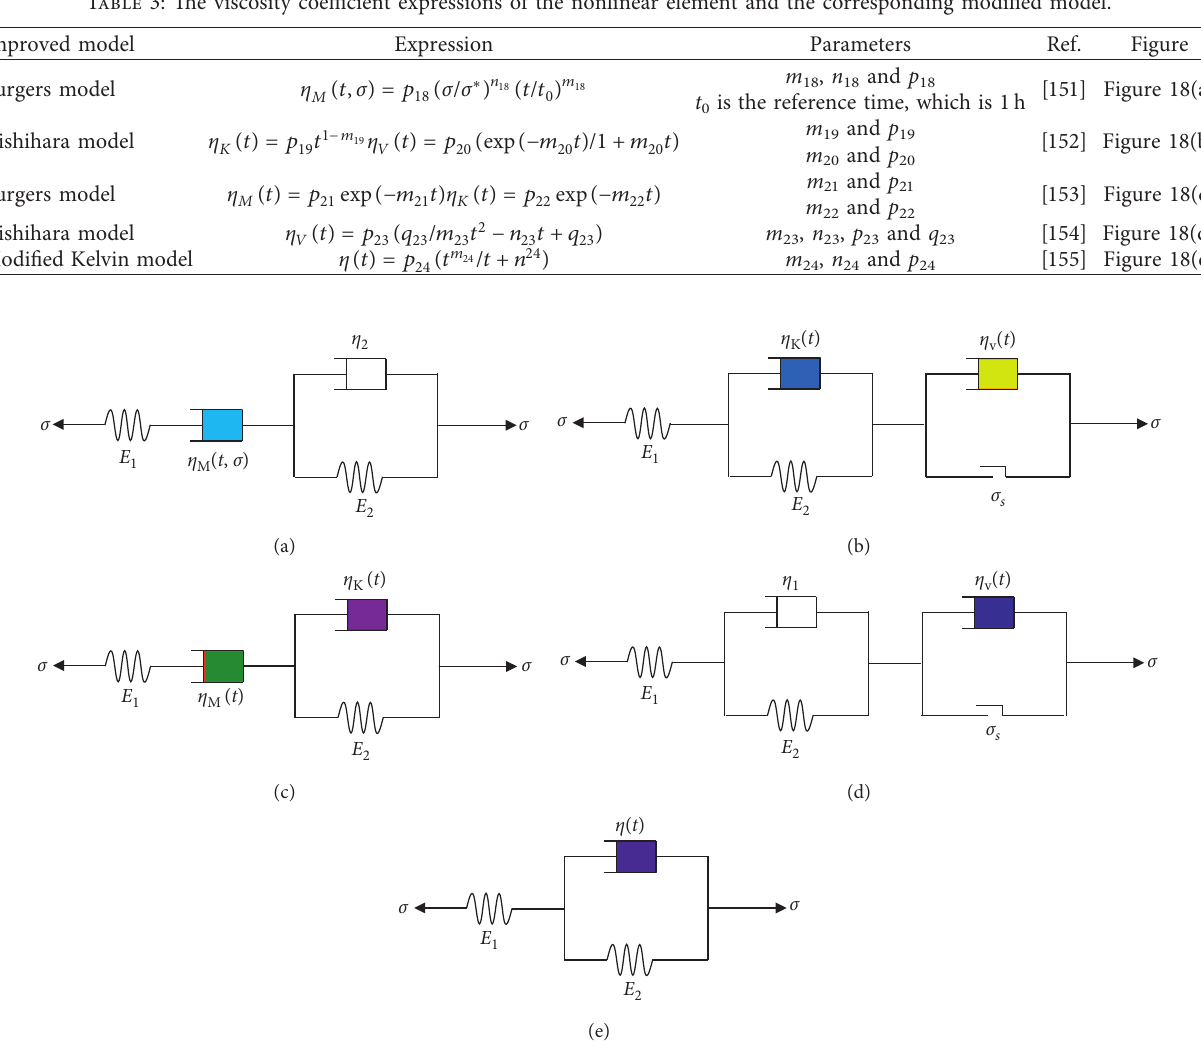
Figure 18: Schematic diagram of the nonlinear creep constitutive model proposed by other scholars (a) improved by Xiong et al. [151], (b) improved by Kang et al. [152], (c) improved by Han et al. [153], (d) improved by He et al. [154], and (e) improved by Liu et al. [155].